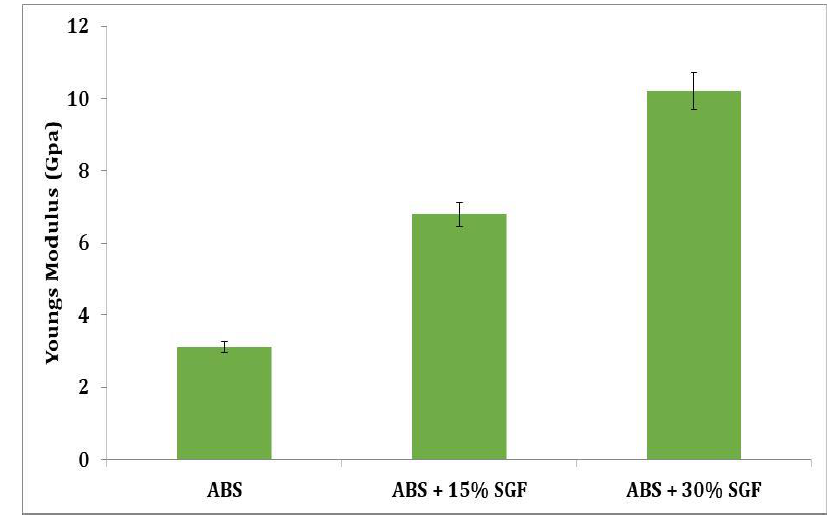
Figure 12. Variation of Y oung’s modulus with short glass fibre content.